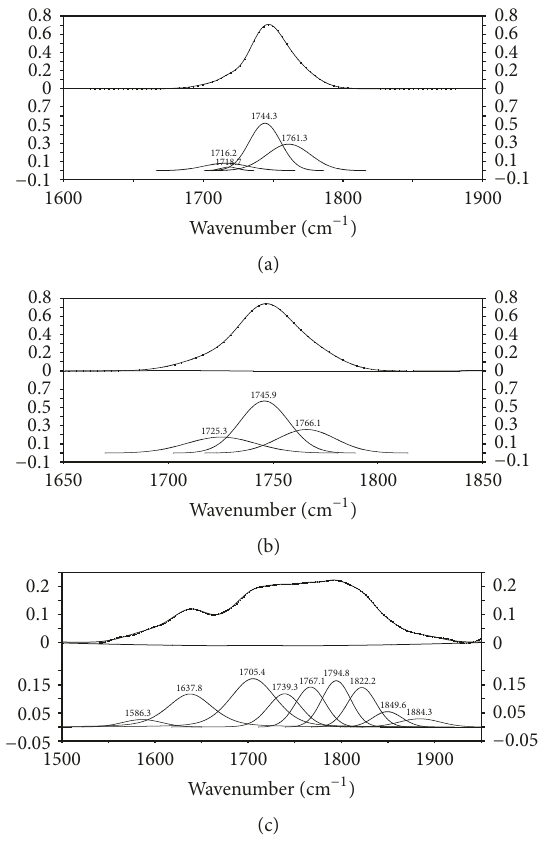
Figure 1: FTIR spectra of poly(lactic acid) 3251D pristine and grafted with maleic anhydride (PLA-g-MA) (a) PLA3251D.csv: Pk = Gauss Amp 4 Peaks; Bg = Quadratic; 𝑟 2 = 0.999868; SE = 0.0023849; 𝐹 = 40098.7. (b) PLA3251D-g-AM 10%: Pk = Gauss Amp 3 Peaks; Bg = Cubic; 𝑟 2 = 0.999971; SE = 0.00150788; 𝐹 = 104650. (c) PLA3251D-g-AM 20%.csv: Pk = Gauss + Lor Amp 9 Peaks; Bg = Quadratic; 𝑟 2 = 0.999411; SE = 0.00210295; 𝐹 = 7770.34.